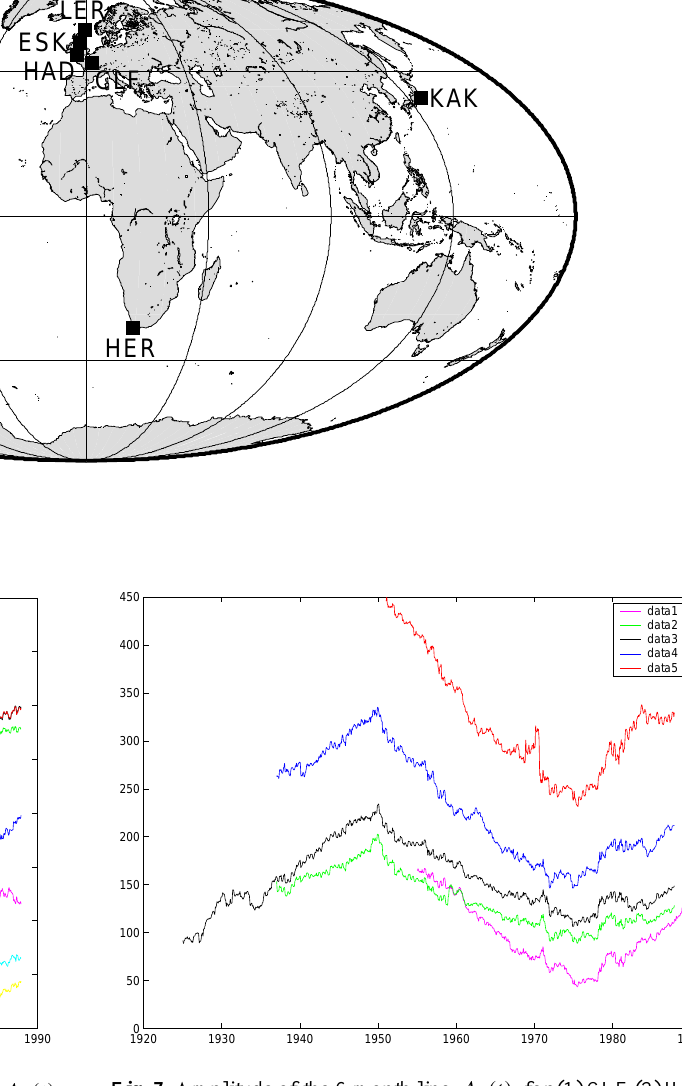
Fig. 6. Variation of the amplitude of the 6-month line, A 6 (t) , when varying the period T 6 around 182,6 days. Vertical unit: .35